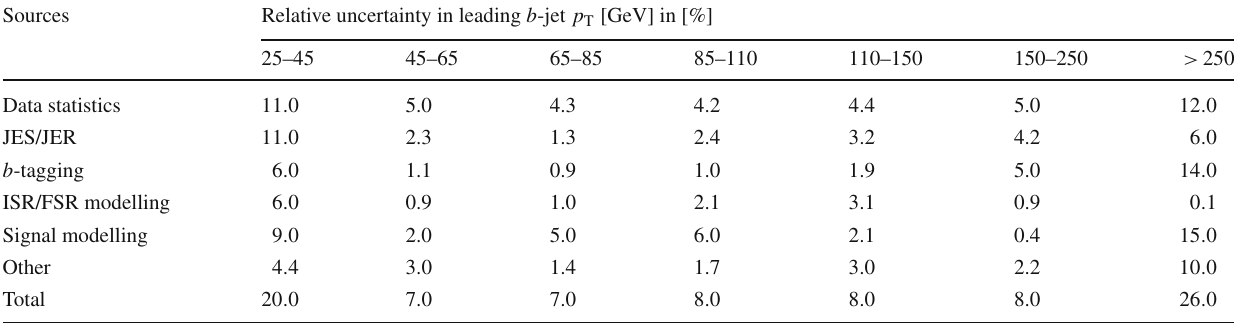
Table 7 Summary of relative measurement uncertainties in [%] for the leading b -jet p T distribution. “Signal modelling” sources of systematic uncertainty includes the hadronisation, parton shower and NLO mod-